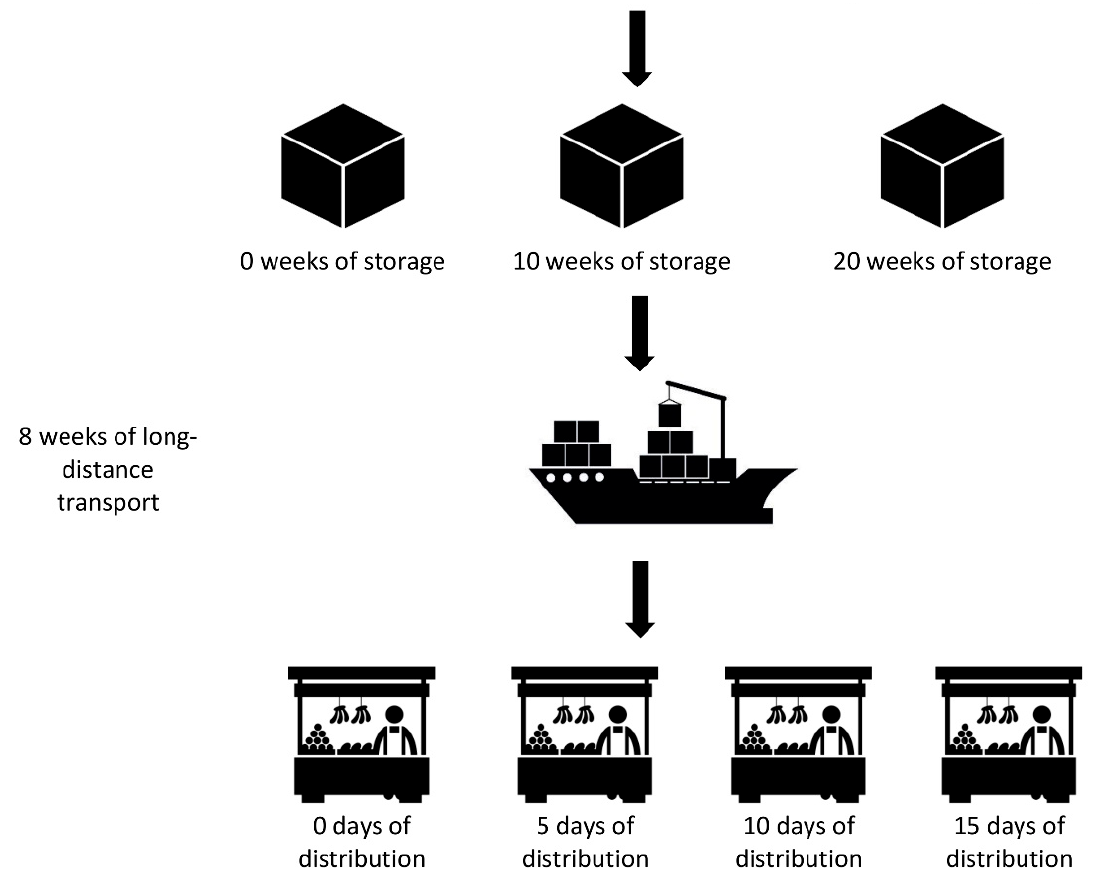
Figure 1. The studied groups of Idared apples; 1-MCP—methylcyclopropene.